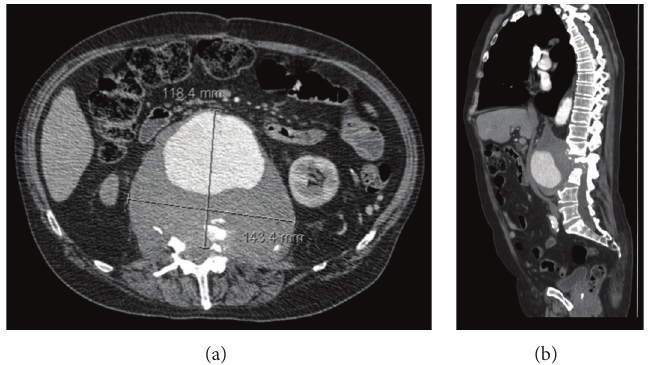
Figure 1: Single images from the CT angiogram scan of the perirenal saccular abdominal pseudoaneurysm with adjacent discitis. (a) Axial image of the pseudoaneurysm 11.8 × 14.3 cm in dimensions. (b) Sagittal image of the pseudoaneurysm with concomitant L1–L3